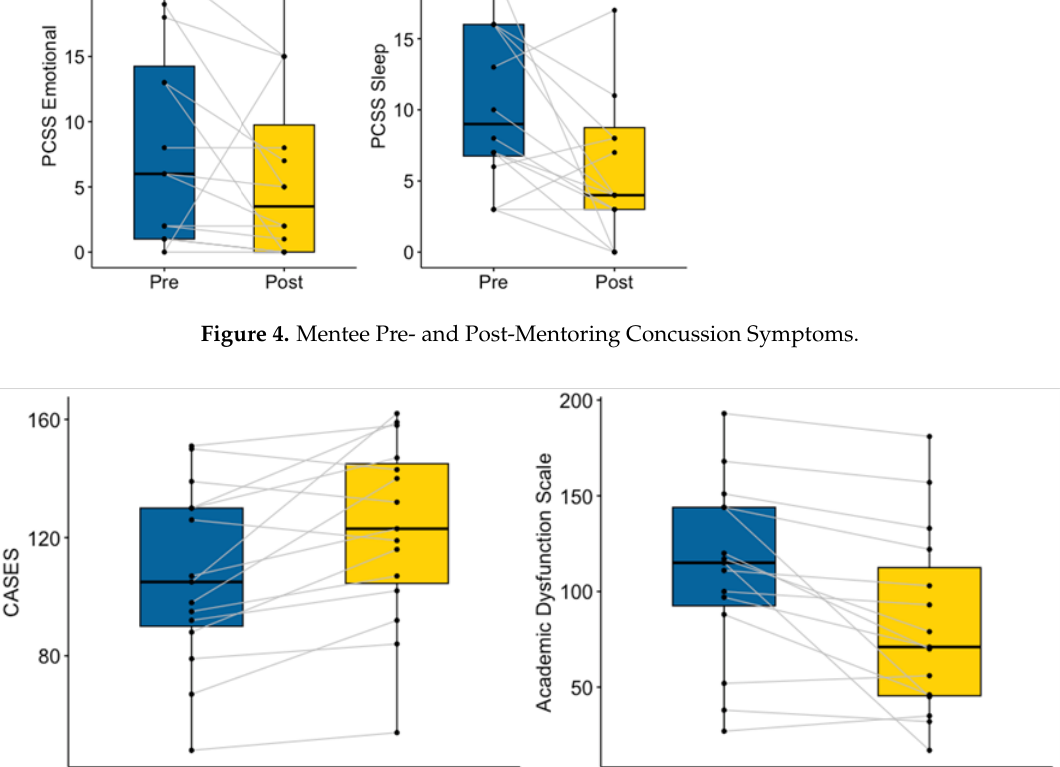
Figure 4. Mentee Pre- and Post-Mentoring Concussion Symptoms.